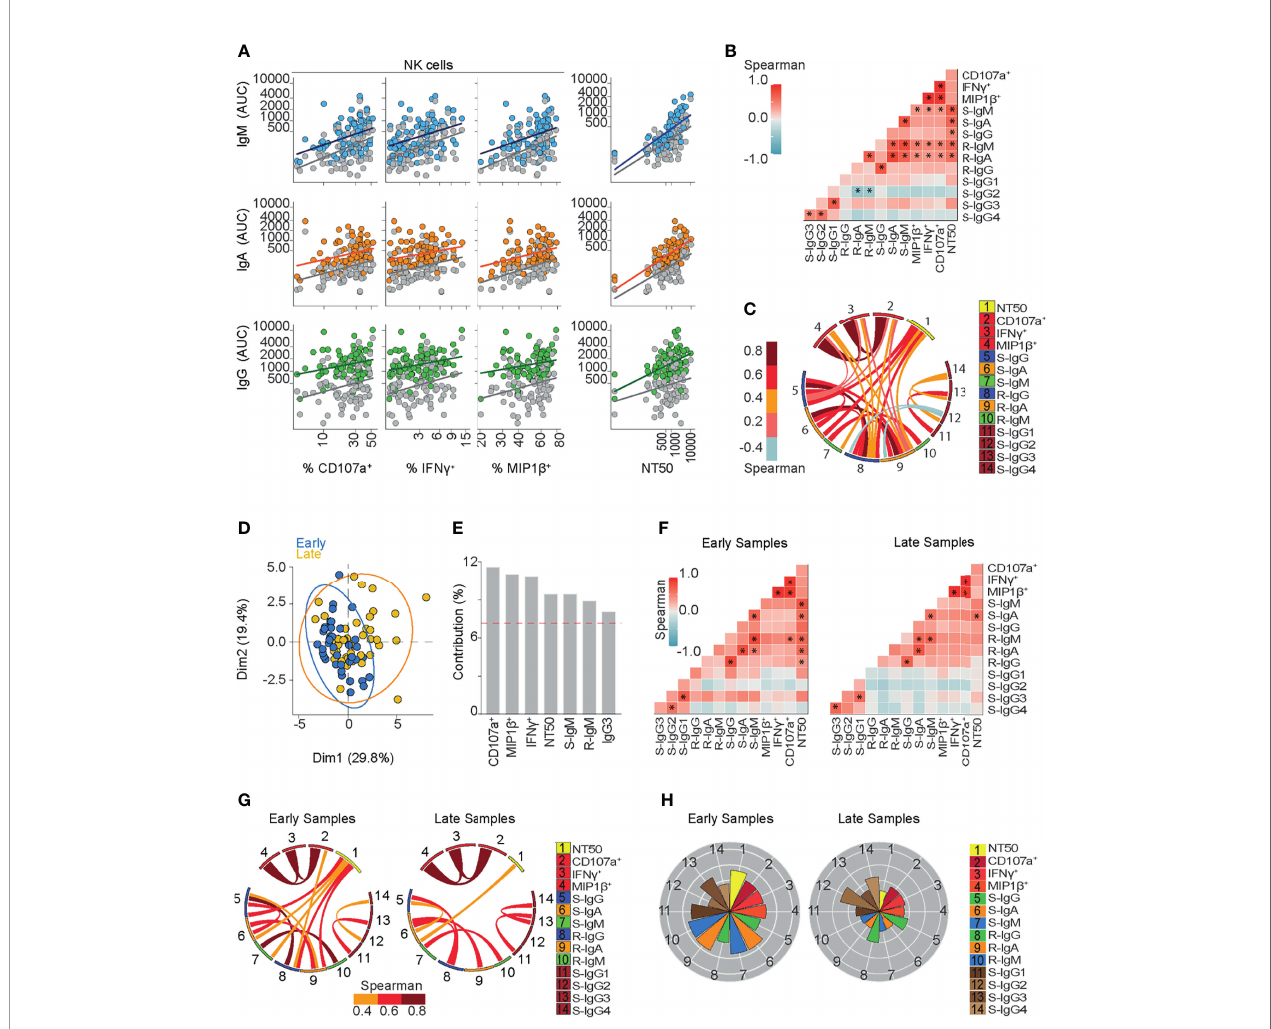
FIGURE 2 | Ab-dependent NK effector functions are represented during the early phase and shown to be sustained six months after symptoms onset in COVID-19 outpatients. (A) A scatter plot showing linear regressions for Spike and RBD-speci fi c titers for IgM, IgA, and IgG antibodies shown as AUC (Area Under Curve) values against their respective Ab-dependent functions: Ab-dependent NK degranulation, shown as the frequency of CD107a + NK cells; Ab-dependent NK activation, shown as the frequency of IFN g + and MIP1 b + NK cells; plus neutralizing ability, shown as NT50 values (83 samples from 70 donors). Colored or gray circles display Spike or RBD-speci fi c titers, respectively. (B) Correlation heatmap showing the Spearman ’ s r values between the complete set of variables analyzed for the entire cohort of COVID-19 outpatients (83 samples from 70 donors). The scale of blue-to-red color indicates a negative-to-positive correlation. Asterisks are shown for statistical signi fi cance of Holm-Bonferroni adjusted for multiple hypothesis testing (*p < 0.05). (C) Circos plot showing the signi fi cant Spearman correlations between the pairs of variables displayed with asterisks in (B) . The color of the links represents the magnitude of Spearman ’ s r values. (D) Biplot showing the principal component analysis (PCA) depicting the “ early ” and “ late ” convalescence samples distinguished based on their sampling from the onset of symptoms (Early ≤ 43 days; Late > 43 days) (83 samples from 70 donors). (E) Contribution of variables for both dimensions (1 and 2) in the PCA analysis. (F) Correlation heatmap showing the Spearman ’ s r values between the complete set of variables analyzed for early-sampled (42 samples from 42 donors) and late-sampled (41 samples from 31 donors) groups of outpatients. A scale of blue-to-red color indicates a negative-to-positive correlation. Asterisks are shown for statistical signi fi cance of Holm- Bonferroni adjusted for multiple hypothesis testing (*p < 0.05). (G) Circos plot showing the signi fi cant Spearman correlations between the pairs of variables displayed with an asterisk in (F) for early-sampled and late-sampled groups of outpatients. The color of the links represents the magnitude of Spearman ’ s r values. (H) Polar plots showing the differential composition of humoral immune responses in different groups. Each bar represents the mean z-scores of variables for early-sampled (42 samples from 42 donors) or late-sampled (41 samples from 31 donors)